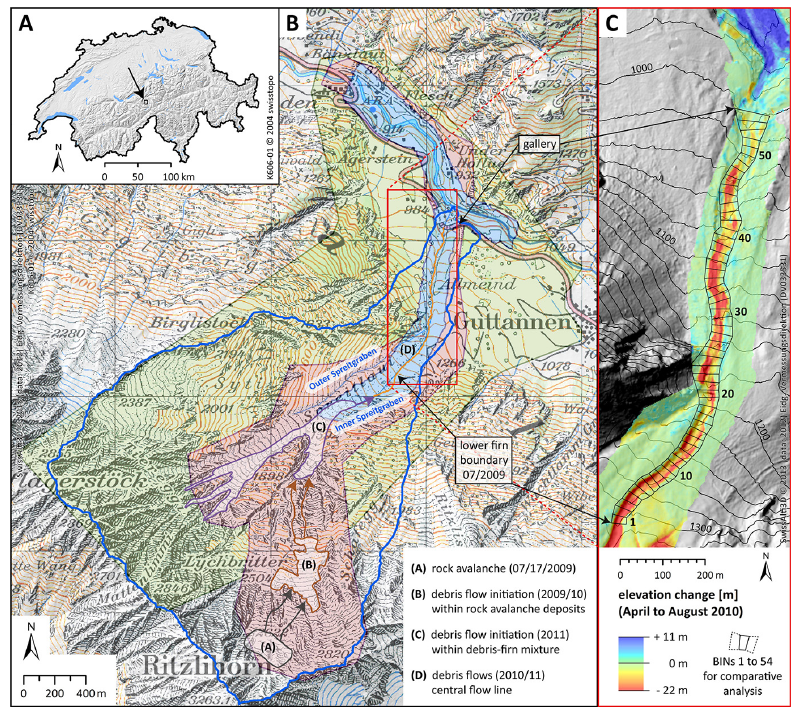
Figure 2. (a) The Spreitgraben catchment in Central Switzerland. (b) The processes observed in the catchment (a) to (d) during the most active years 2009 to 2011 and the coverage of the three available lidar-based digital terrain models DTM (2010 and 2011) for the erosion analysis: 04/2010 (raster cell: 2m, blue polygon); 08/2010 (raster cell: 1m, red polygon); 10/2011 (raster cell: 1m, green polygon). (c) The elevation change (04/2010 to 08/2010) on the middle and lower fan are compared to erosion modeling results using bins numbered 1 to 54. Table 1. Data available for the erosion (modeling) analysis for the Spreitgraben (Geotest, 2012). The erosion depth and digital elevation models (DTM) provide the basis for the elevation change data